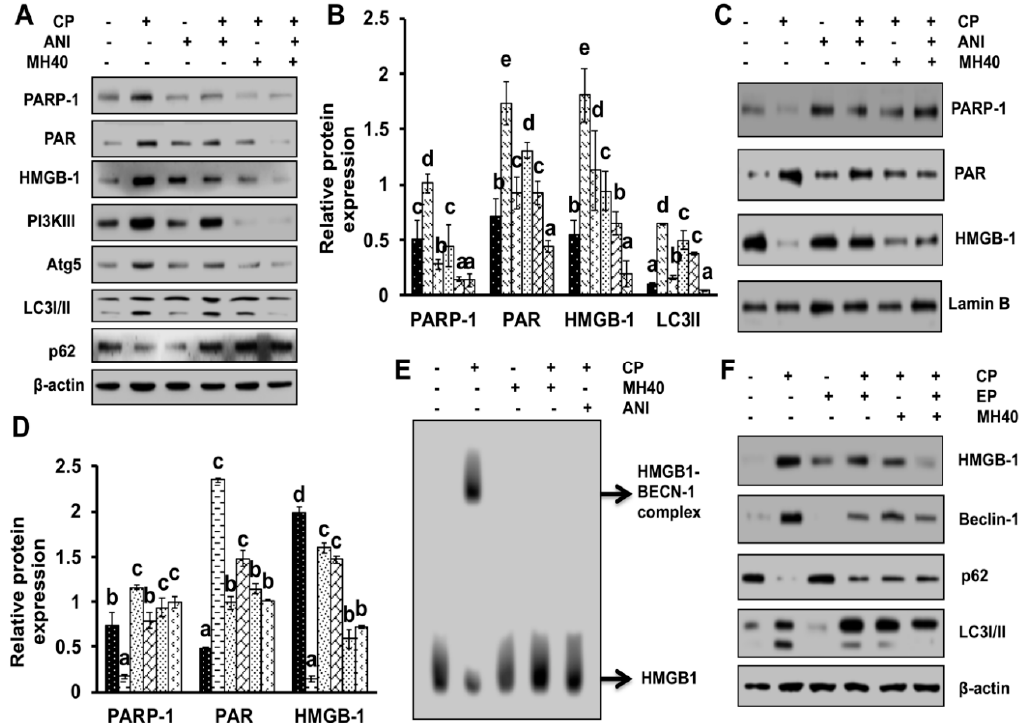
Figure 8. Effect of PARP-1 inhibitor ANI and MH on expression, translocation and release of HMGB1 in HepG2 cells. ( A ) Western blotting of cytosolic proteins was performed using specific antibodies against PARP-1, PAR, HMGB1, PI3KIII, Atg5, LC3I/II and p62 after treatment with CP, MH and ANI alone and in combination. Results are normalized with β -actin in respective controls. ( B ) Relative expression of PARP-1, PAR, HMGB1 and LC3I/II analyzed by densitometry analysis using ImageJ software. ( C ) The expression level of nuclear proteins was analyzed using antibodies against PARP-1, PAR and HMGB1 after treatment with CP, MH and ANI alone and in combination. Results are normalized to Lamin B in respective controls. ( D ) Relative expression of PARP-1, PAR and HMGB1 LC3I/II was measured by densitometry analysis using ImageJ software. ( E ) The HMGB1-Beclin1 interaction was evaluated by native gel after corresponding drug treatment. ( F ) The expression level of cytosolic proteins was analyzed using specific antibodies for HMGB1, Beclin-1, p62 and LC3I/II after treatment with CP, MH and EP alone and in combination. β -actin was used as an internal loading control. The data are presented as means standard deviation ( n = 3). Values with different letters (a–e) differ significantly from each other ( p < 0.05).